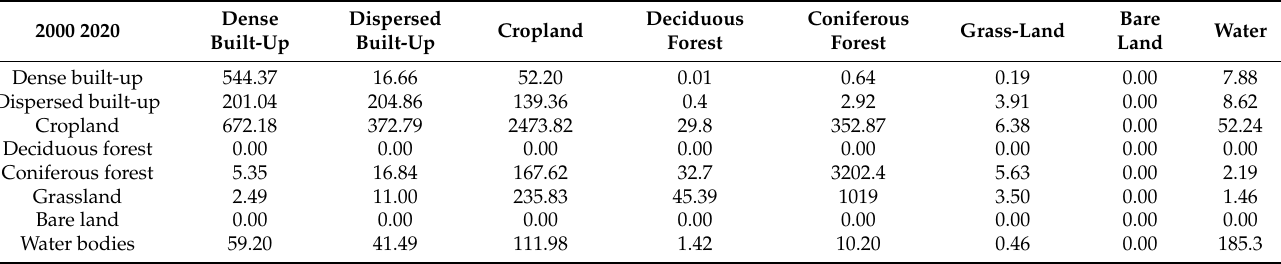
Table A7. Land cover area transfer matrix for Ningbo from 2000 to 2020 (km 2